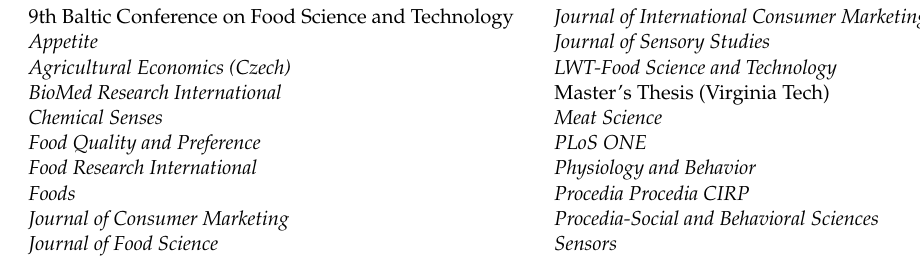
Table 3. List of sources from the systematic literature review (in alphabetical order).